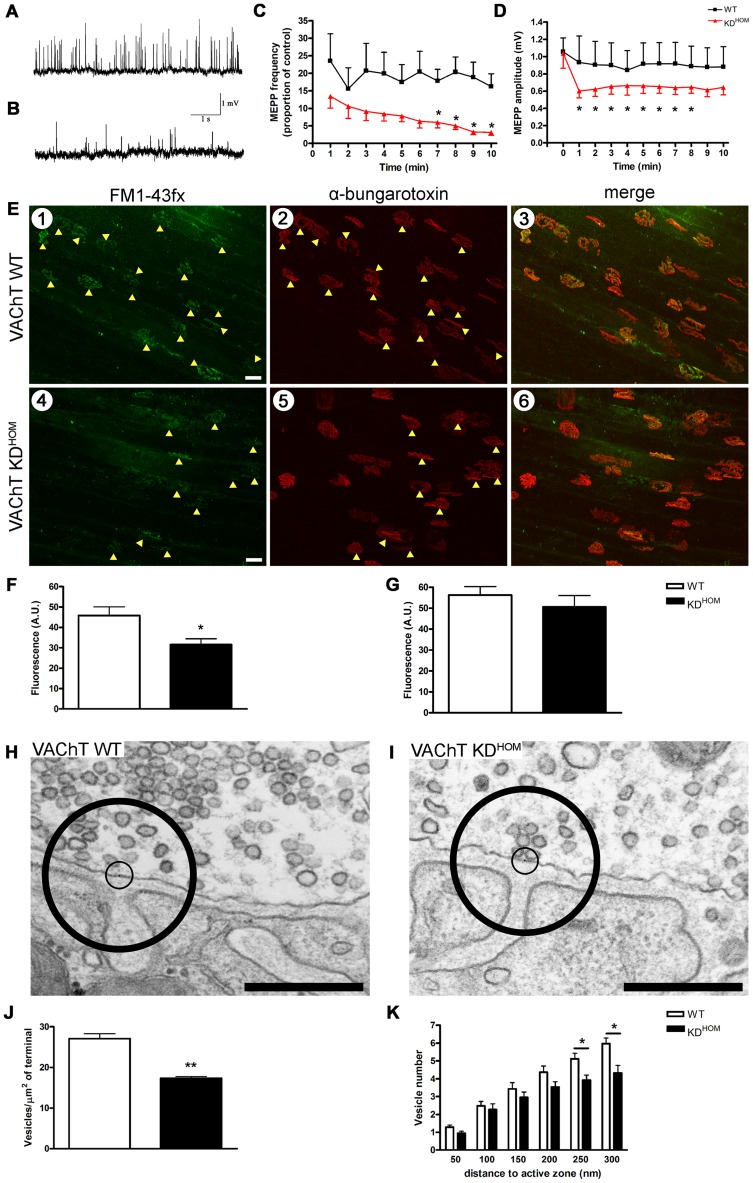
Alteration in SVs recycling and distribution after hypertonic sucrose stimulation in VAChT KDHOM NMJs.A and B – Representative records of MEPPs obtained from the diaphragm muscle of VAChT WT and VAChT KDHOM mice, respectively, measured in the presence of hypertonic sucrose solution (500 mM) at the end of 10 minutes. C -Graph comparing the mean values of normalized MEPPs frequency measured in the presence of hypertonic sucrose during 10 minutes. The results were normalized using the basal MEPPs values for each genotype. D – Graph showing the mean values of MEPP amplitude before (time zero) and during 10 minutes in hypertonic solution. In C and D all results are expressed as mean ± SEM. * p<0.05; n = 4 animals per genotype E– Confocal representative images of NMJs from the diaphragm muscle of VAChT WT (E1–E3) and VAChT KDHOM mice (E4–E6): E1 and E4– presynaptic terminals stained with FM1-43 fx after hypertonic stimulation for 10 min; E2 and E5– postsynaptic nAChR clusters stained with α-bungarotoxin-Alexa 594; E3 and E6– colocalization of synaptic elements. Scale bar  = 10 μm. F– Graph showing the fluorescence intensity of the presynaptic terminal in arbitrary units (A.U.) (* p<0.05). G– Graph comparing the fluorescence intensity of the postsynaptic nAChR clusters in arbitrary units (A.U.). (n = 3 animals of each genotype). H and I– Representative electron-micrographs of two diaphragm NMJs profiles of VAChT WT and VAChT KDHOM mice after hypertonic stimulation for 10 min, showing altered distribution and reduced number of SVs inside the areas labeled within the circles: 50 and 300 nm from the membrane, small and big circles respectively. Scale bar  = 500 nm. Magnification 50.000x. J– Graph comparing the relationship of SVs/μm2 of presynaptic terminal. (** p<0.01). K– Graph showing the average number of SVs located at different distances from the presynaptic active zones. (n = 3 individual animals per genotype; * p<0.05).